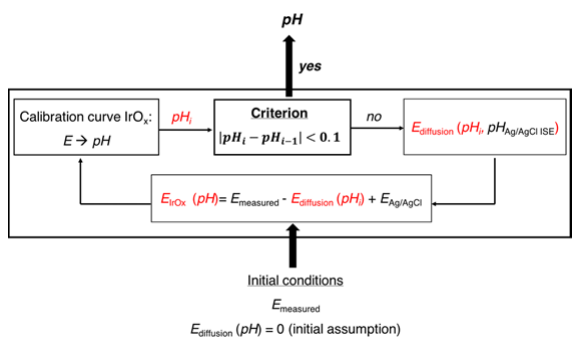
Figure 3. Representation of the iterative calculation procedure used to determine the pH of the pore solution with embedded IrO x sensors as the mortar sample carbonates. The parameters changed in each iteration are indicated in red. The calculated pH in each iteration ( pH i ) is specifically indicated in the diagram.